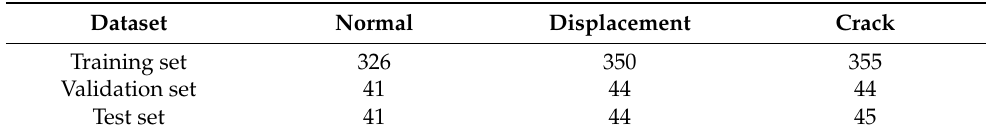
Table 1. Data sample distribution.